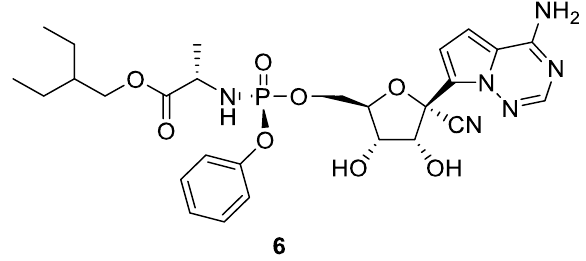
Figure 3. Chemical structure of remdesivir ( 6 ).